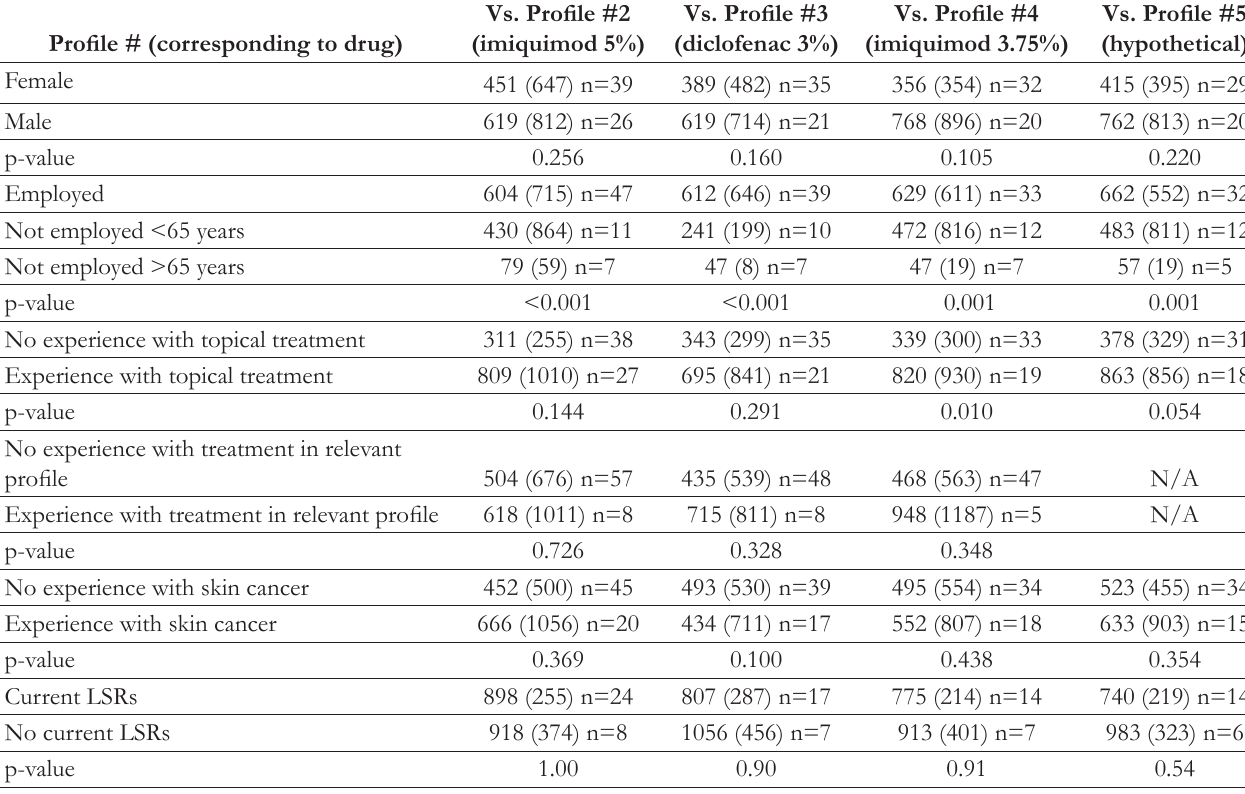
Table 3. Incremental WTP in Subgroups, Subjects willing to pay extra for the Profile of Ingenol Mebutate Gel Profile # (corresponding to